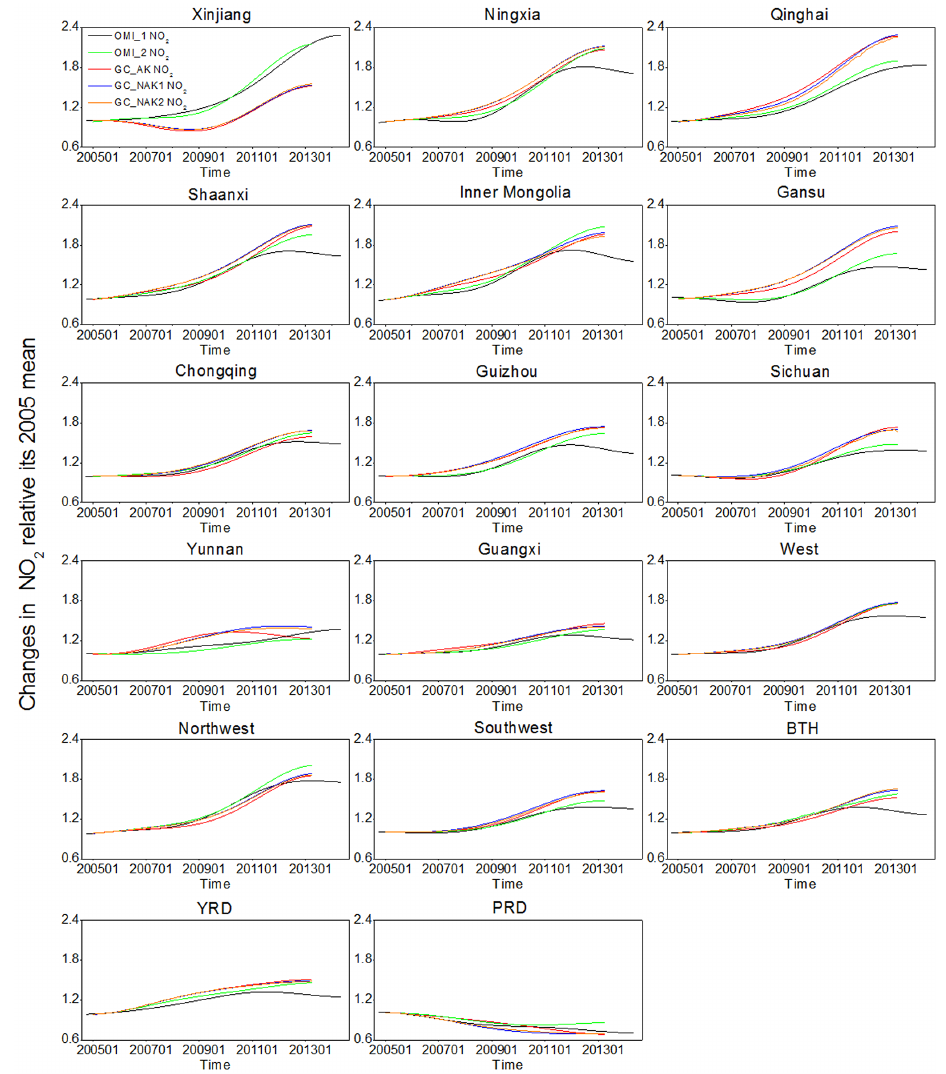
Figure 6. The long-term trends (i.e., the A 5 component out of the wavelet analysis) of OMI and modeled NO 2 in individual provinces and regions. The values are normalized to 2005. OMI_1 (black line) denotes the A 5 signal from a wavelet analysis of OMI NO 2 over October 2004–May 2014, and OMI_2 (green line) corresponds to the wavelet analysis over January 2005–April 2013. GC_AK (red line) corresponds to a wavelet analysis of coincident modeled values (applied with the AK) over January 2005–April 2013. GC_NAK1 (blue line) represents the A 5 signal for modeled NO 2 on all days (without applying the AK) over January 2005–April 2013, and GC_NAK2 (orange line) is similar to GC_NAK1 but with model results coincident with valid OMI